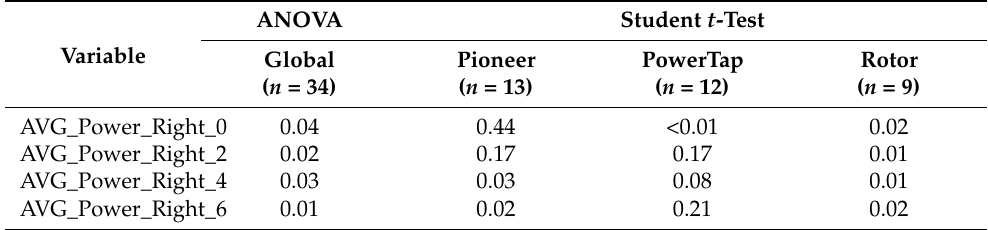
Table 3. Contrast tests for the